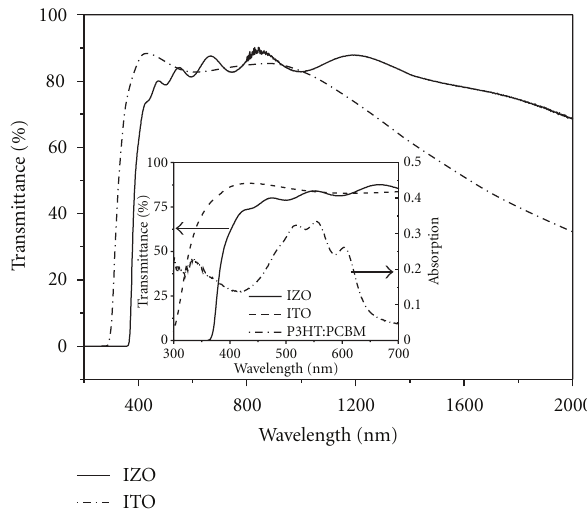
Figure 2: Transmittance of IZO- and ITO-coated glass substrates from ultraviolet to near-infrared region. Inset indicates transmit- tance of IZO- and ITO-coated glass substrates with respect to the absorbance of the P3HT:PCBM